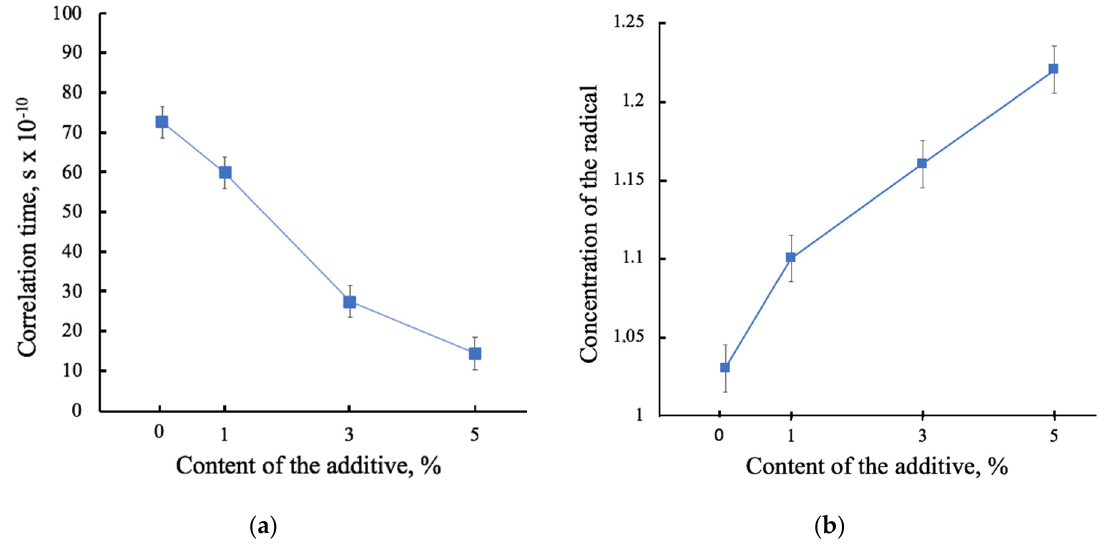
Figure 8. The dependence of the characteristics of the amorphous phase of PHB on the hemin concentration: spin probe correlation times ( a ) and the concentration of the spin probe in relation to the mass of the material sample ( b ).